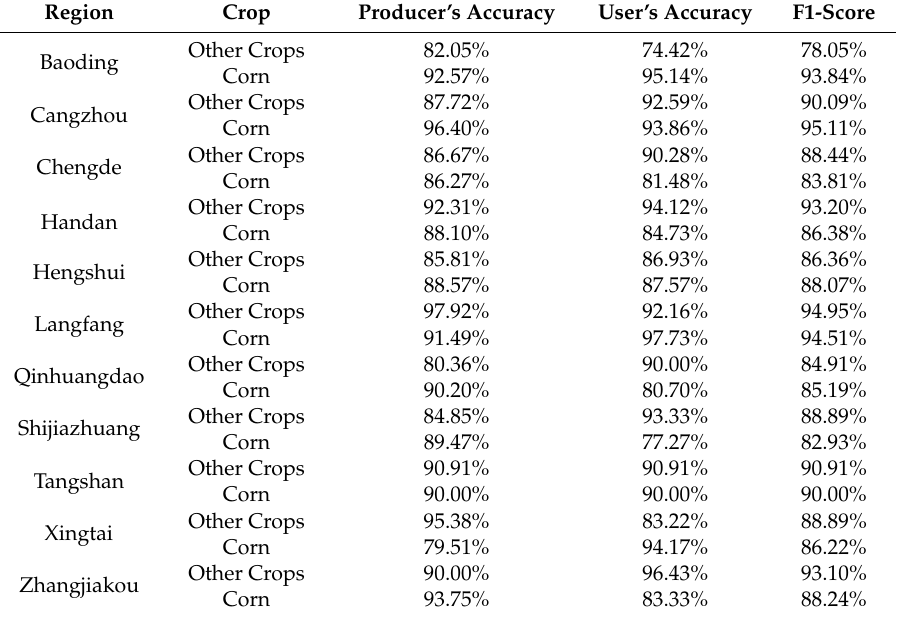
Table 2. Corn map accuracy in each prefecture-level city validated by the testing